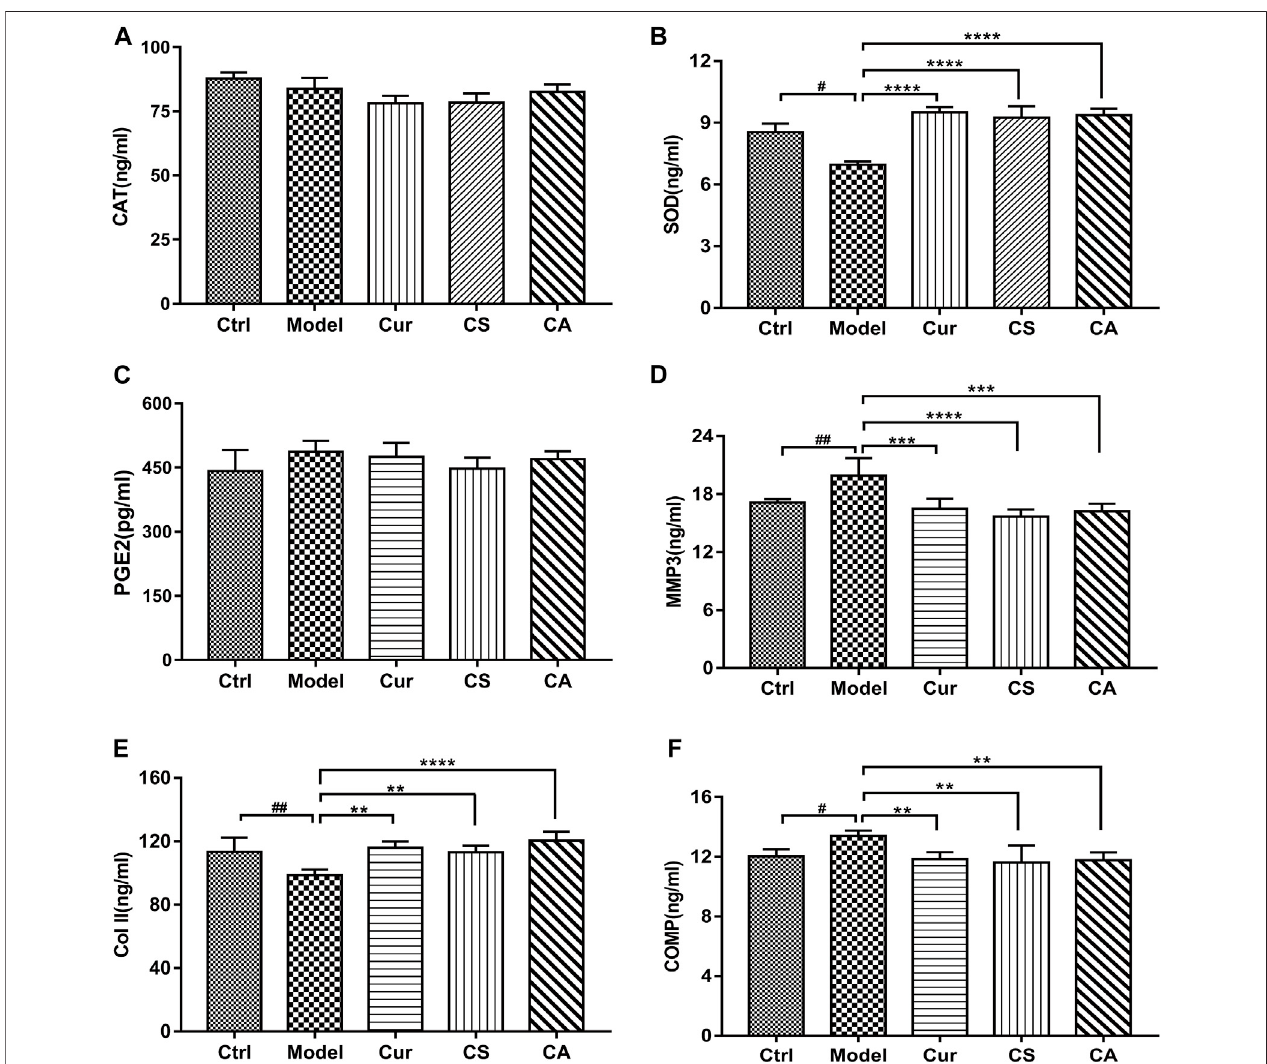
FIGURE 5 | Determination of the contents of CAT, SOD, PGE2, MMP3, Col-II, and COMP in each group. (A) Levels of CAT in serum. (B) Levels of SOD in serum. (C) Levels of PGE2 in serum. (D) Levels of MMP3 in serum. (E) Levels of collagen II in articular cavity fl uid. (F) Levels of COMP in articular cavity fl uid. Data are presented as the mean ± SD ( n = 5). # p < 0.05 vs. Ctrl group; * p < 0.05, ** p < 0.01, *** p < 0.001, **** p < 0.0001 vs. model